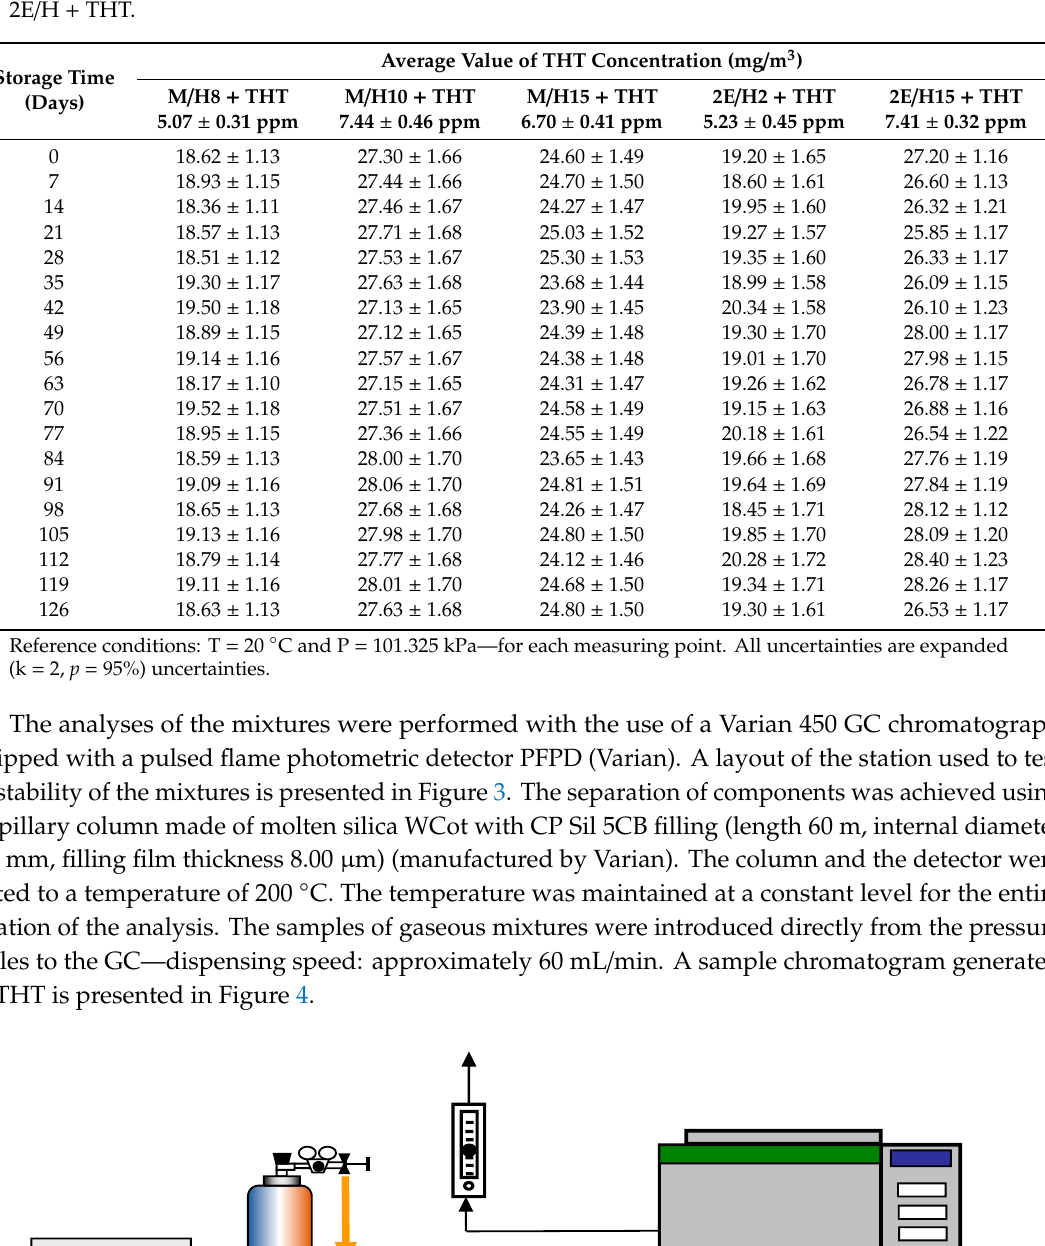
Table 3. Results of testing the stability of THT concentration in gaseous mixtures of M / H + THT or 2E / H + THT.